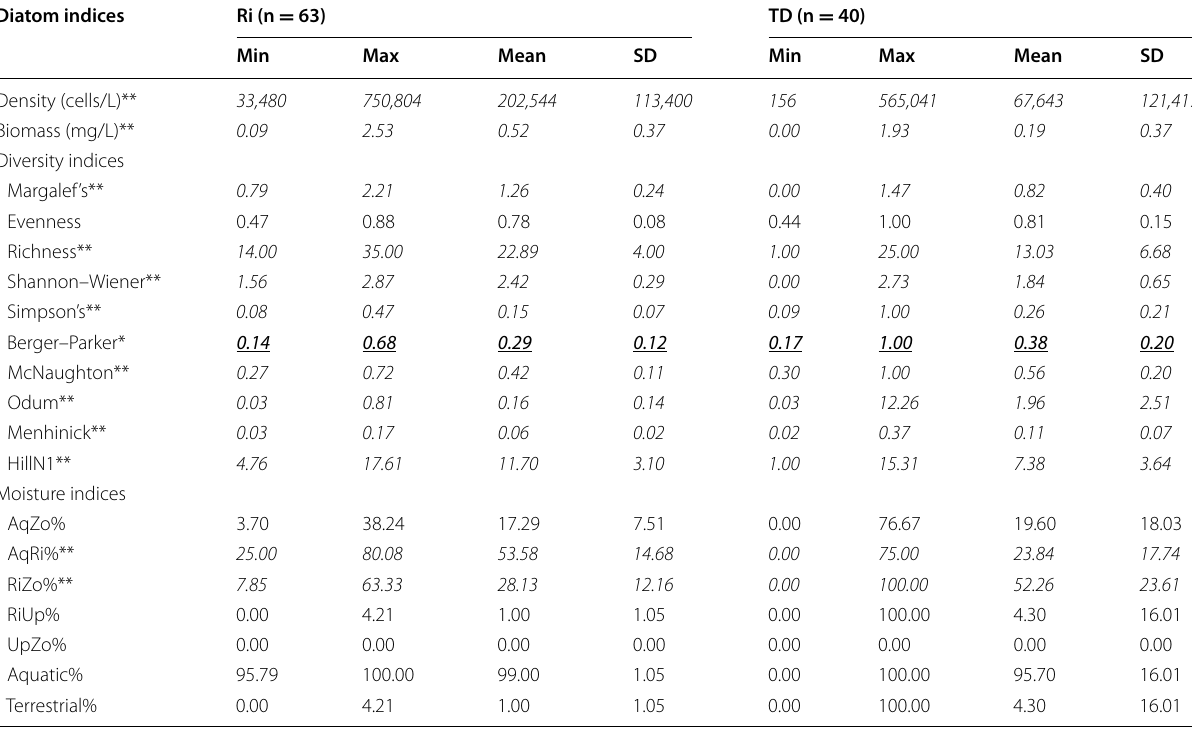
AqZo Aquatic zone, AqRi Aquatic/Riparian transition zone, RiZo Riparian zone, RiUp Riparian/Upland transition zone, UpZo Upland